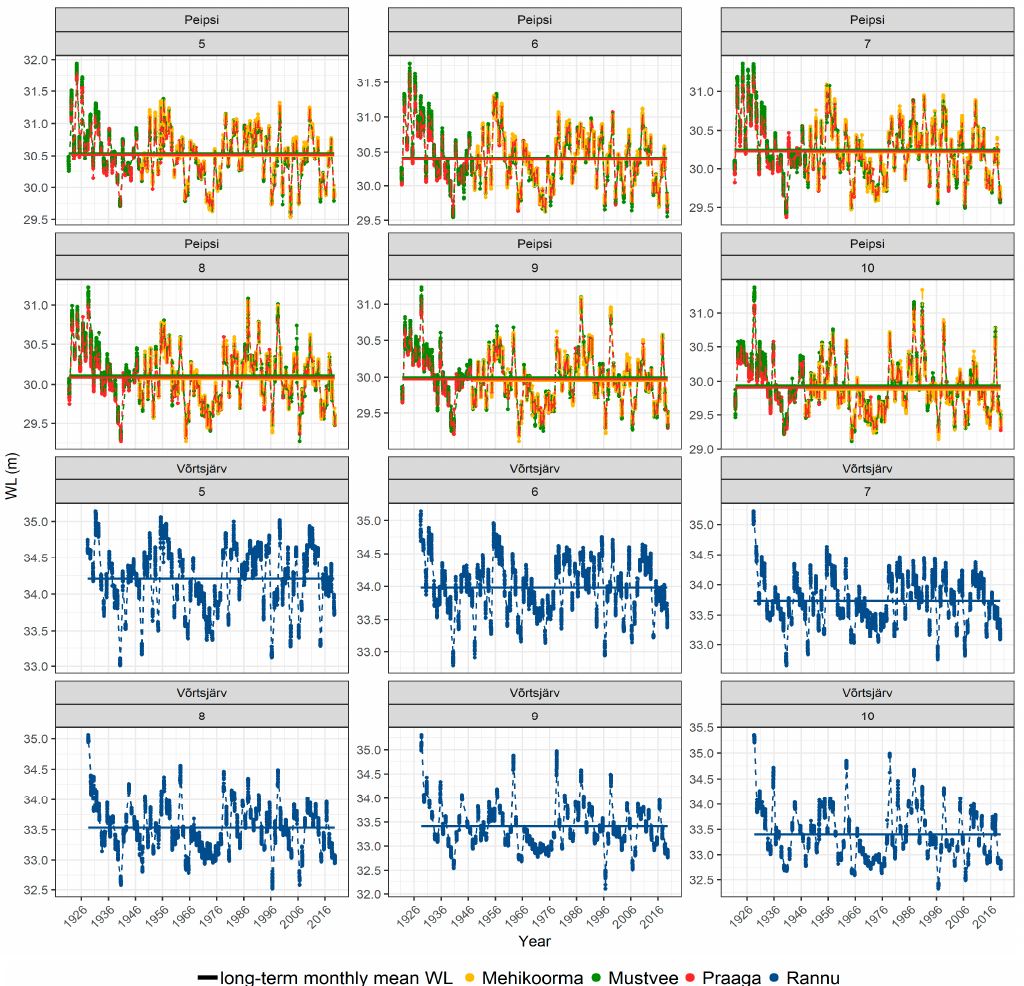
Figure 2. Long-term water level (WL) in Rannu, Mustvee, Praaga, and Mehikoorma hydrometric stations from May (5) to October (10). Long-term monthly mean WL is showed in solid line.